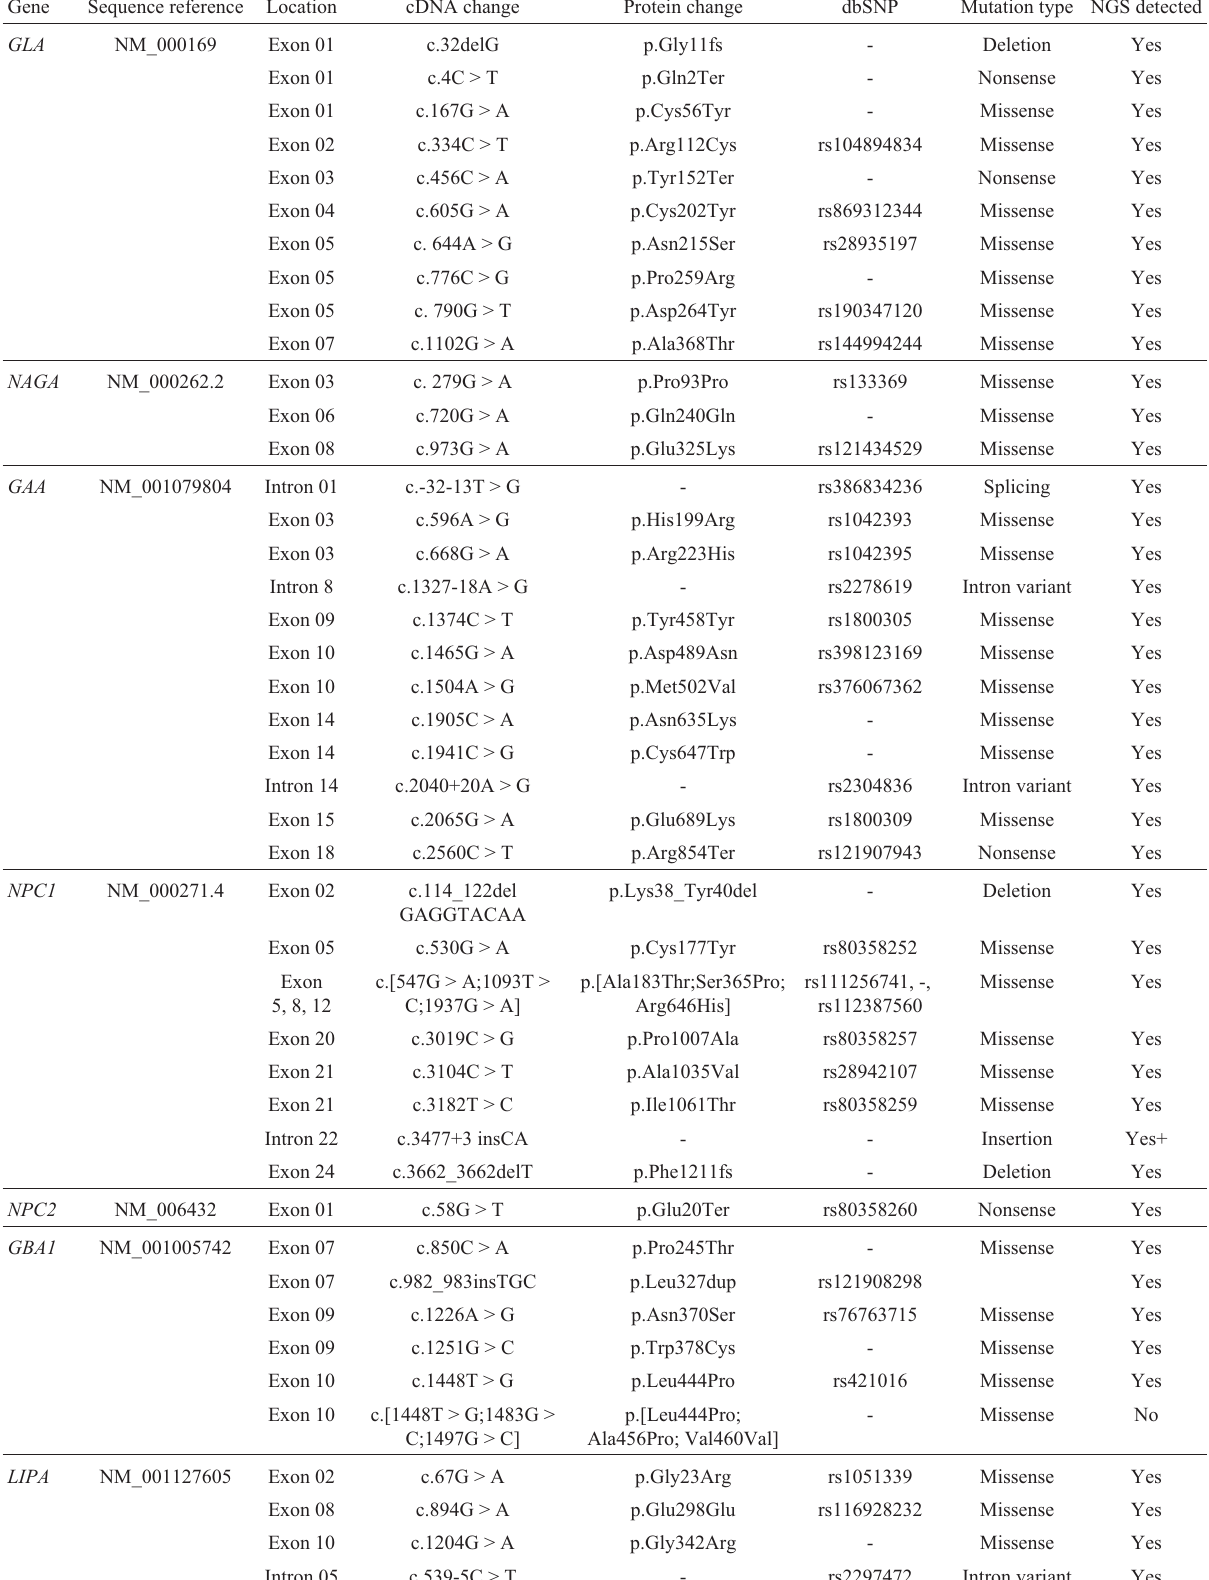
Table 4 - Variants detected in this study by TNGS and Sanger